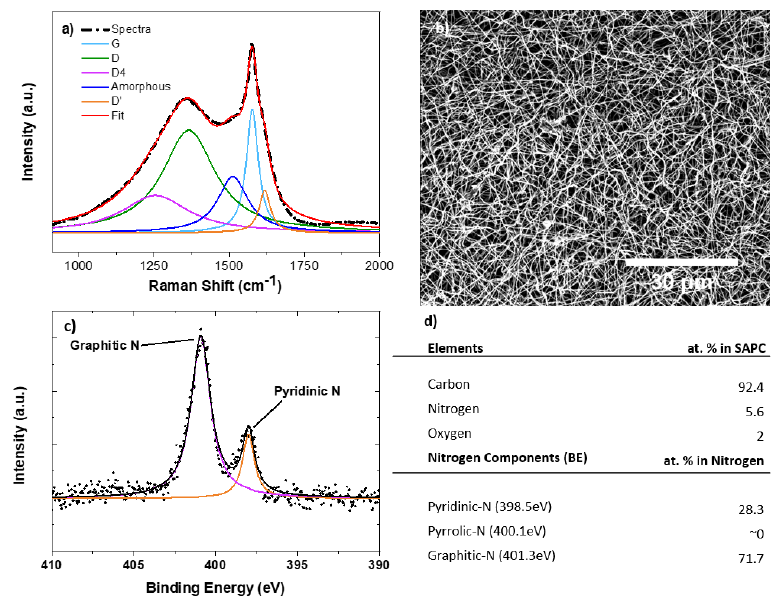
Figure 2. ( a ) Raman spectrum with fitted Lorentzian curves for MCNF electrodes. More than 100 Raman spectra collections ( λ excitation = 532 nm) were averaged to analyze MCNF; ( b ) Scanning electron micrograph of MCNF’s; ( c ) XPS N 1s peak of MCNF; ( d ) Elemental composition of the carbon electrodes as analyzed from XPS.